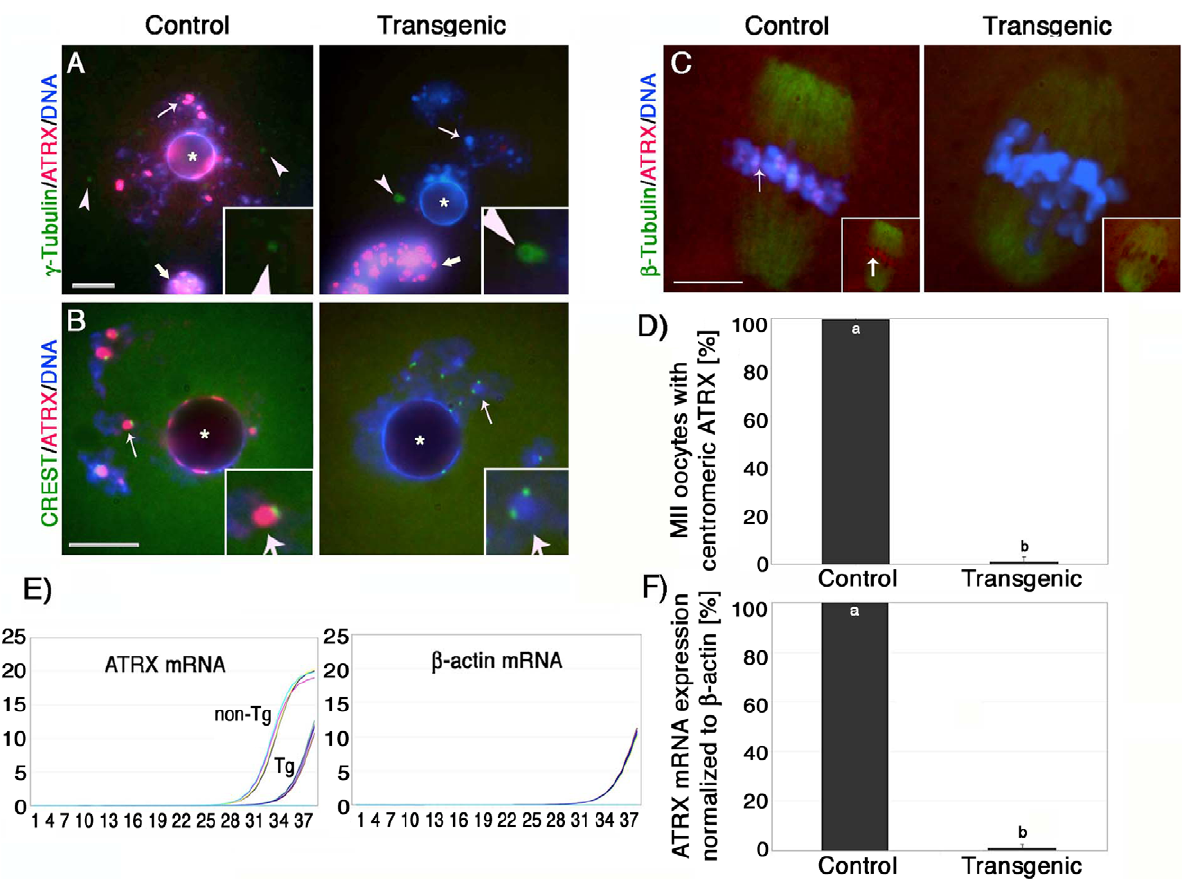
Figure 1. Oocyte-specific ablation of the ATRX protein in a transgenic RNAi mouse model. ( A ) Nucleus of control oocyte showing bright ATRX staining (red, left image) at heterochromatin domains (arrow) as well as c -tubulin signals (green) towards the nuclear periphery (arrowheads and inset). No ATRX staining is detectable in the nucleus of transgenic oocytes (arrow, right image). However, c -tubulin staining remained unaffected (arrowheads and inset). Note that ATRX protein is expressed in surrounding somatic granulosa cells in both control and transgenic animals (bold arrows). The position of the nucleolus is indicated by (*). ( B ) Partial co-localization of ATRX and CREST signals at pericentric heterochromatin domains in control oocytes (arrow and inset, left image). By contrast, while localization of CREST signals is unaffected in transgenic oocytes (arrow and inset, right image), ATRX is not detectable at DAPI-bright heterochromatin domains. ( C ) Control MII oocyte immunostained with ATRX (red, arrow) and b - tubulin (green) showing proper chromosome alignment at the metaphase II spindle (left image, arrow, inset shows ATRX/ b -tubulin merge only). Lack of ATRX in transgenic oocytes (right image, inset) results in abnormal chromosome alignment. ( D ) Proportion of in vivo matured MII stage oocytes that exhibited ATRX at centromeric heterochromatin. ( E–F ) Quantitative analysis of Atrx transcripts by real-time PCR revealed a significant reduction (p , 0.001) in the levels of Atrx mRNA in transgenic (Tg) oocytes compared with controls (non-Tg). Analysis of b -actin mRNA was used as a housekeeping control. All data are presented as the mean 6 s.d. of three independent experiments. Scale bars =10 m m.